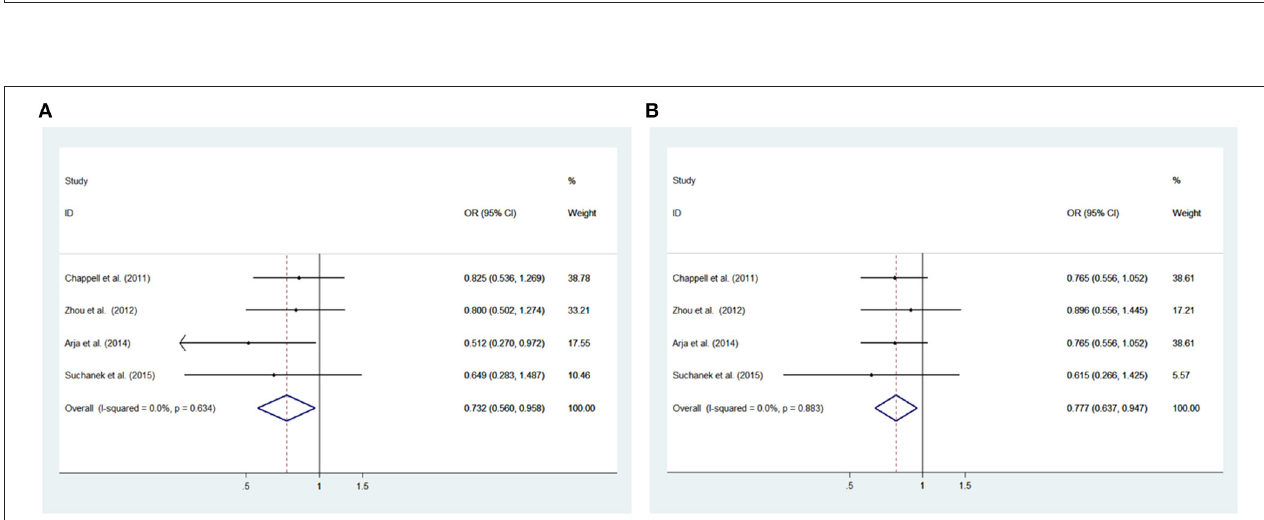
FIGURE 4 | Meta-analysis with a fixed effects model for the association between the IREB2 rs10851906 polymorphism and COPD susceptibility. (A) Recessive model, GG vs. AA + AG. (B) Additive model, GG vs. AA. OR, odds ratio; CI, confidence interval; I-squared: measure to quantify the degree of heterogeneity in meta-analyses.